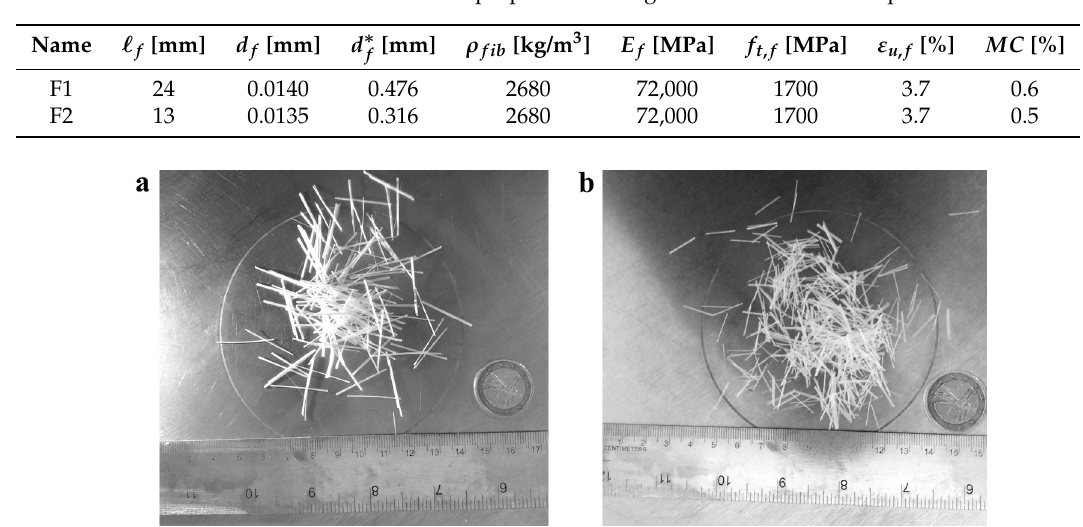
Table 1. Geometrical and mechanical properties of the glass fiber used in the experiments.